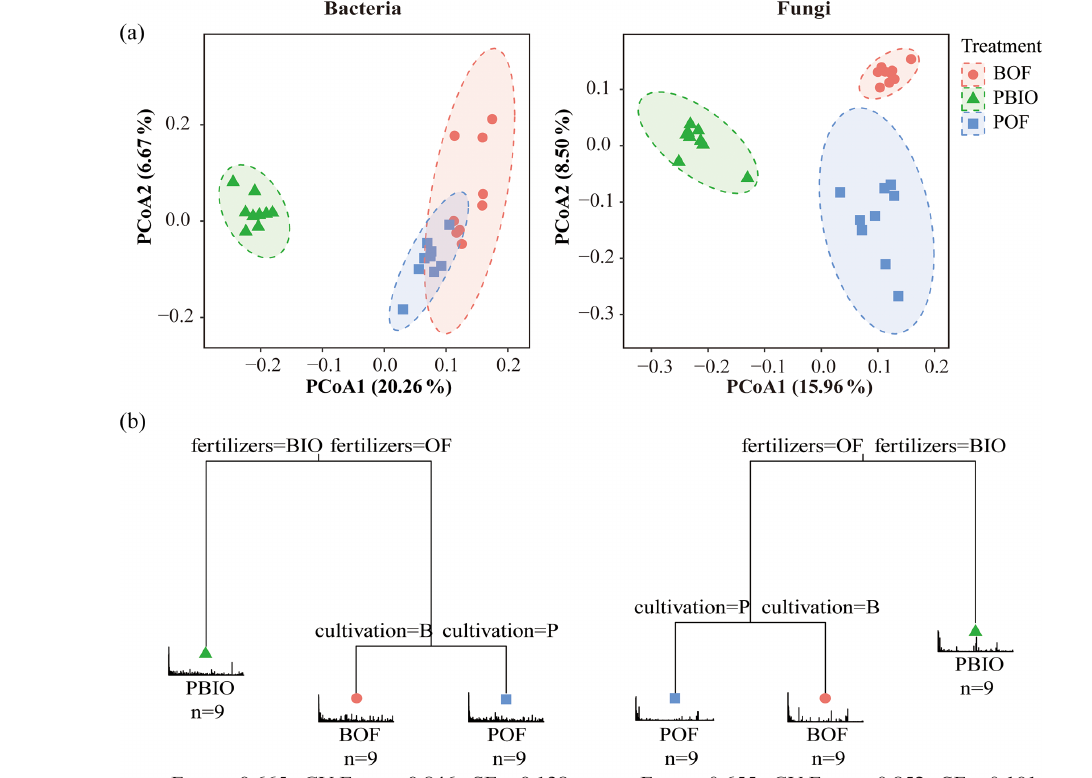
Figure 3. (a) UniFrac-unweighted principal coordinate analysis of fungal and bacterial community structures in different treatments. (b) Mul- tiple regression tree (MRT) analysis for the bacterial and fungal communities showed the variables of fertilization and cultivation in each branch. BOF – banana continuously cropped with OF application; POF – banana–pineapple rotation with OF application in the banana season; PBIO – banana–pineapple rotation with BIO application in the banana